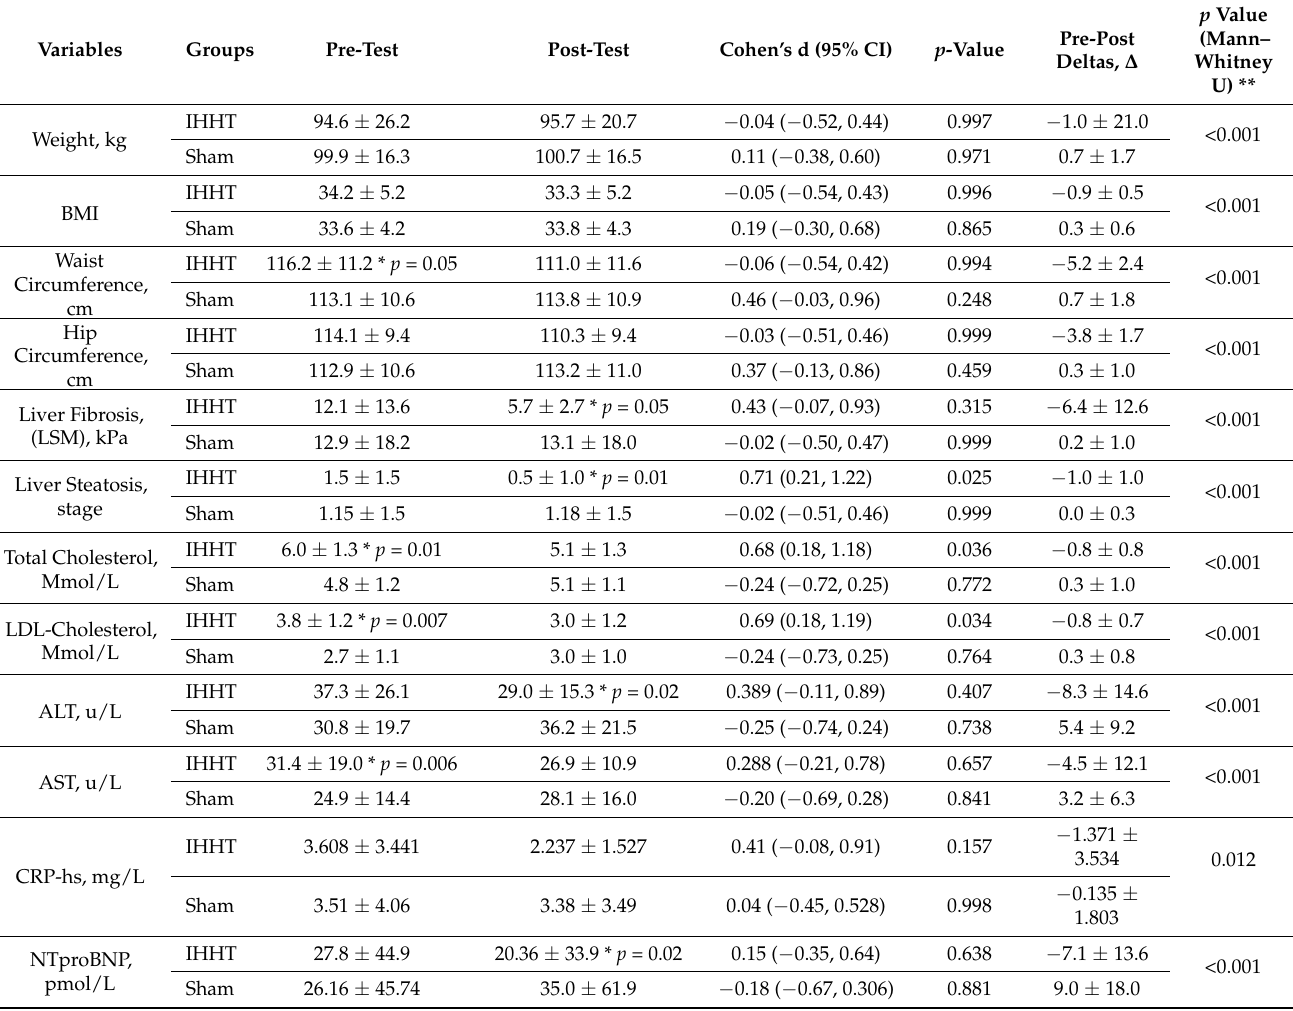
Table 3. Pre- and post-intervention data for metabolic and liver function parameters with the main analysis of covariance results and